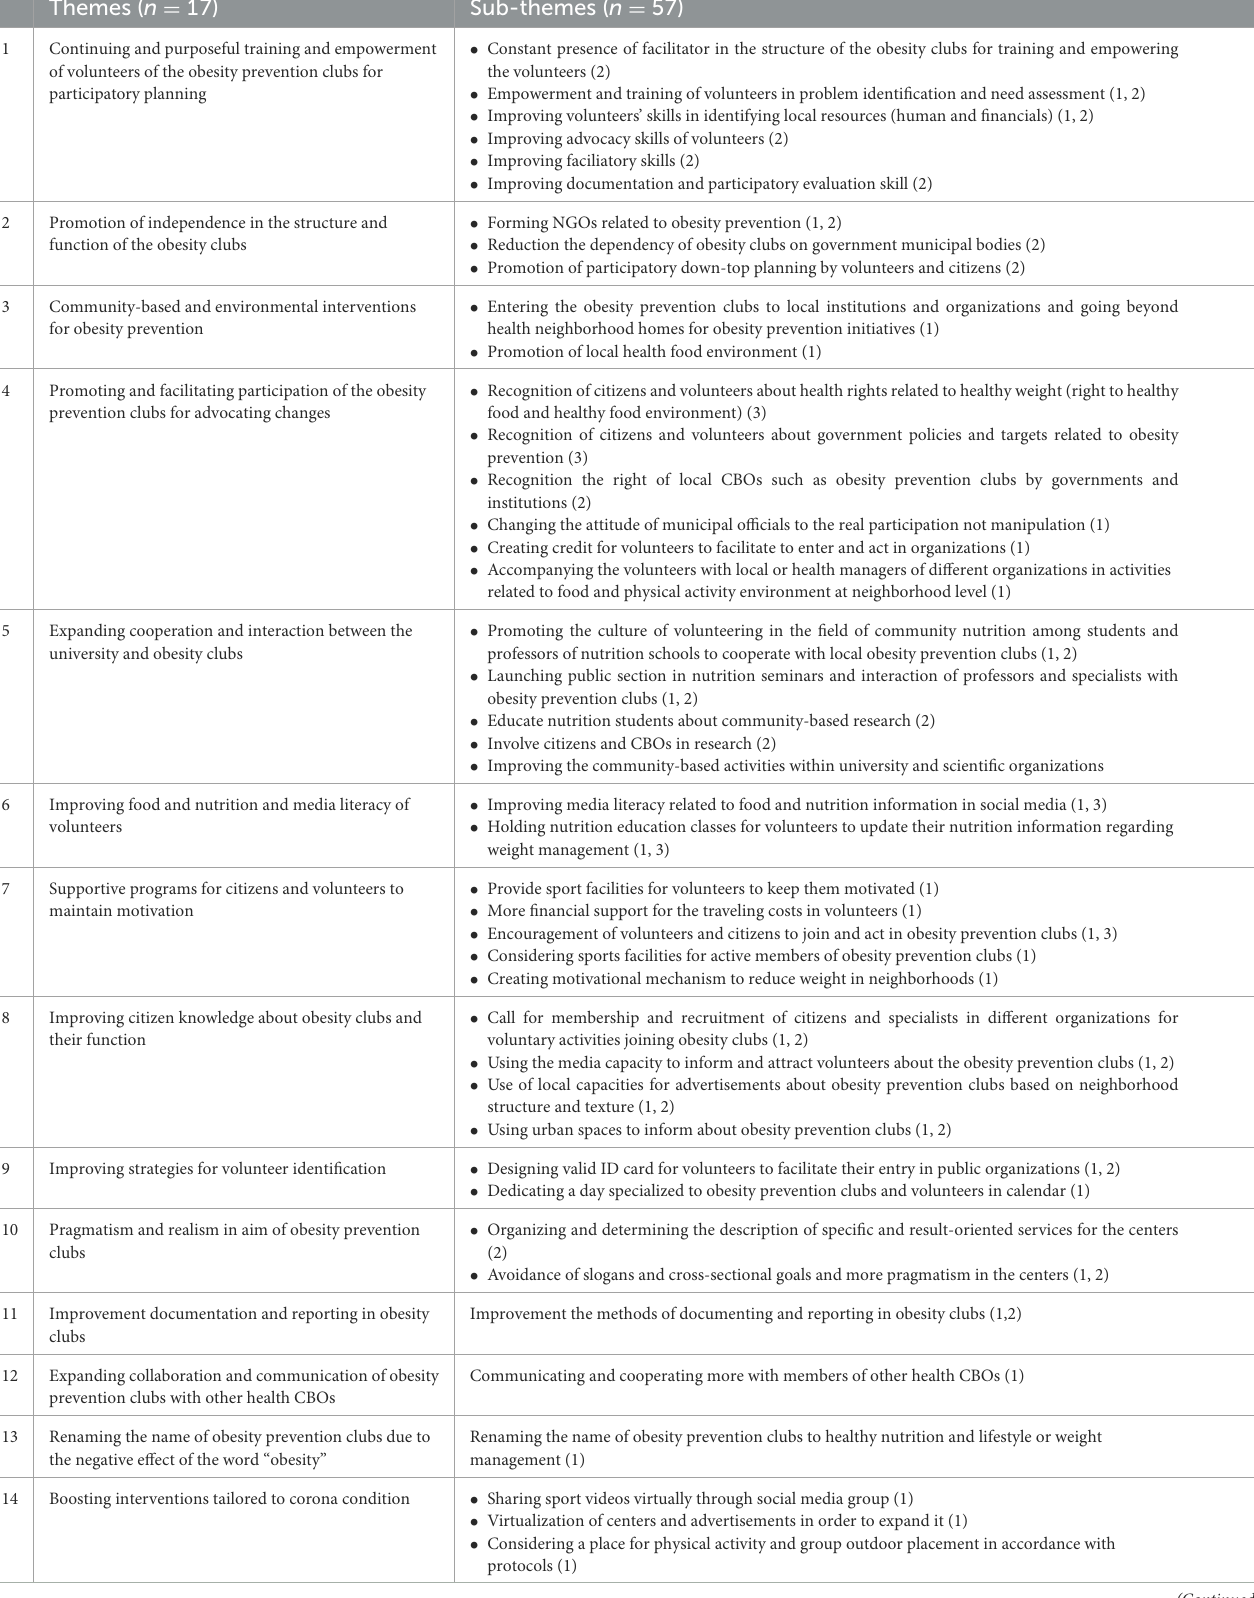
TABLE 4 Suggestions to improve function of health clubs in obesity prevention programs. Themes ( n =